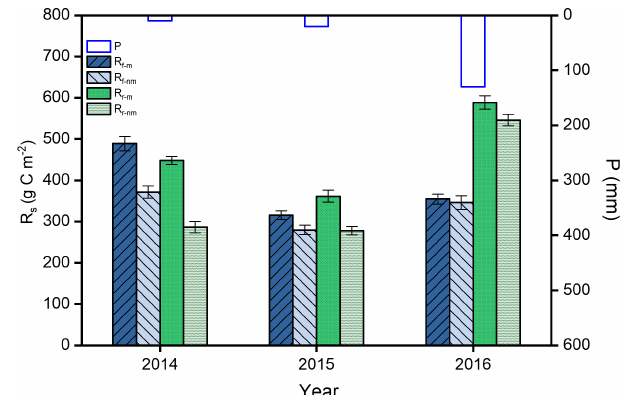
Figure 4. Seasonal accumulative soil respiration and precipitation over the three experimental years. The whiskers represent stan- dard deviations (f-m and r-m represent the furrow and ridge in the mulched field, respectively; f-nm and r-nm represent the furrow and ridge in the non-mulched field,